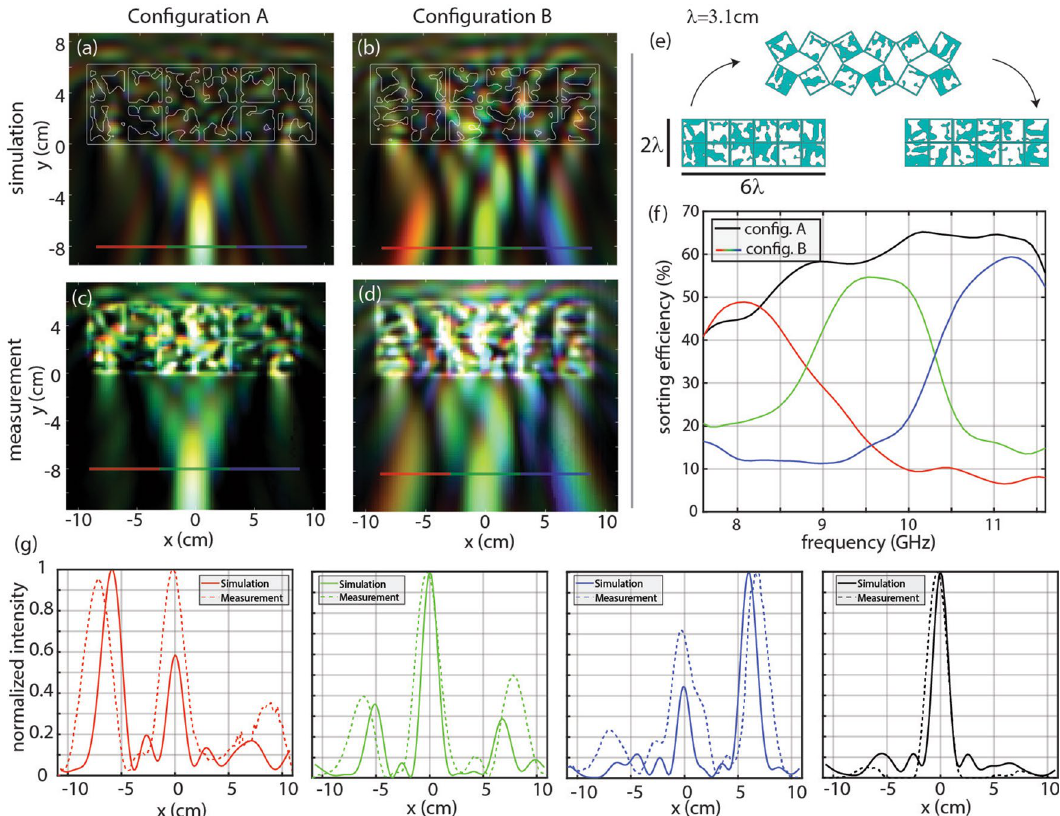
Figure 3. The device performing broadband focusing in one configuration and spectral splitting in the other configuration. ( a ) Broadband focusing simulation, ( b ) spectral splitting simulation, ( c ) broadband focusing measurement, and ( d ) spectral splitting measurement. ( e ) Demonstration of the transformation and device footprint, where blue represents PLA and white represents air. The footprint of the device is 6.2 cm × 18.6 cm. ( f ) Analysis of the focal plane of this device, showing the sorting efficiency for each function, defined as the fraction of incident power reaching the target pixel. Red, green, and blue light are focused to their respectively colored pixels, and sorting efficiency is drawn in red, green, and blue, respectively. The broadband focusing function focuses all light to the middle pixel and is drawn in black. ( g ) Comparison of simulated and measured normalized intensity profiles at the focal plane. Configuration B intensities are integrated over (left) 7.6– 8.9 GHz, (center-left) 8.9–10.2 GHz, (center-right) 10.2–11.6 GHz. (right) Configuration A intensity integrated from 7.6 to 11.6